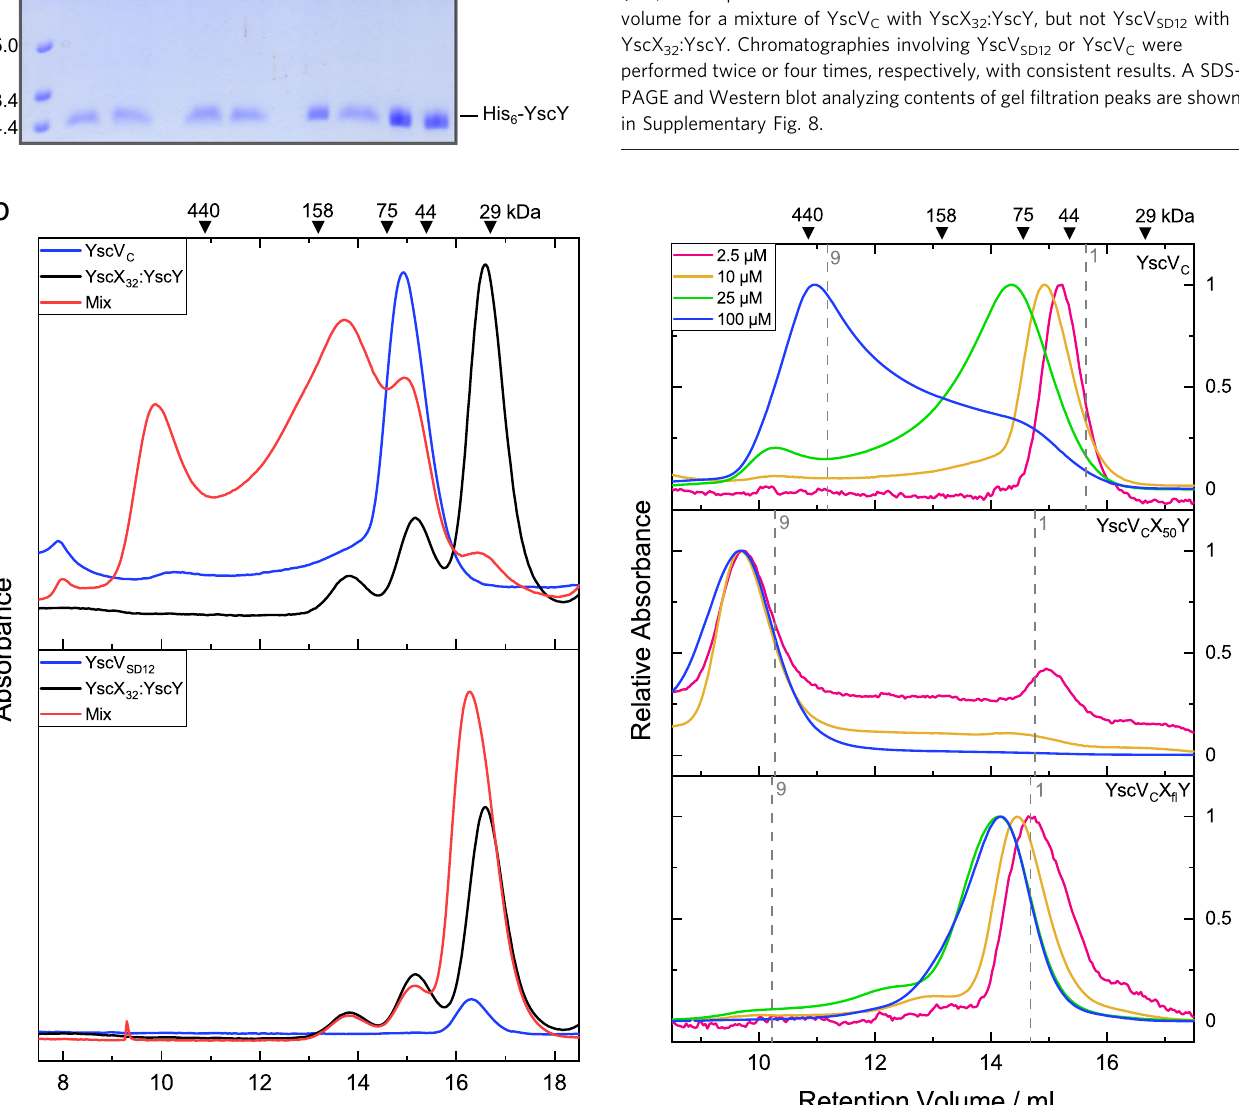
Fig. 7 Concentration-dependent nonamerization of YscV C . For comparability, absorbances were normalized to the highest peak. From top to bottom: YscV C , a ternary complex of YscV C co-expressed with YscX 50 and His 6 -YscY, and the same ternary complex but with full-length YscX (YscX fl ) were loaded at 2.5 µ M (pink) to 100 µ M (blue) onto a Superdex 200 column. For reference, the expected retention volumes for the monomeric species (or 1:1:1 heterotrimer) and nonameric species (assuming 9:9:9 stoichiometry and a globular shape) are shown as dashed gray lines. The weak auto-nonamerization of YscV C is enhanced by the presence of YscX 50 but severely impeded by full-length YscX. Experiments were performed three times with consistent